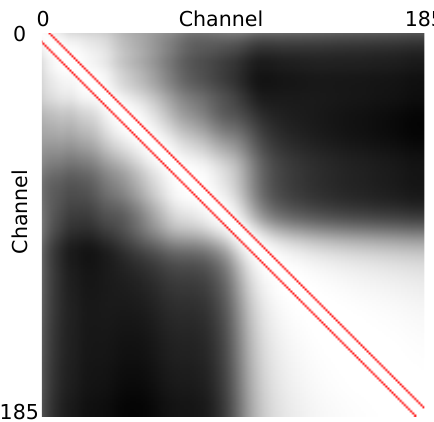
Figure 15. Normalized covariance between each couple of channels over the whole dataset. Values range between 31% ( black ) and 100% ( white ). The two red lines are separated by seven channels, and inside the red lines, the covariance is above